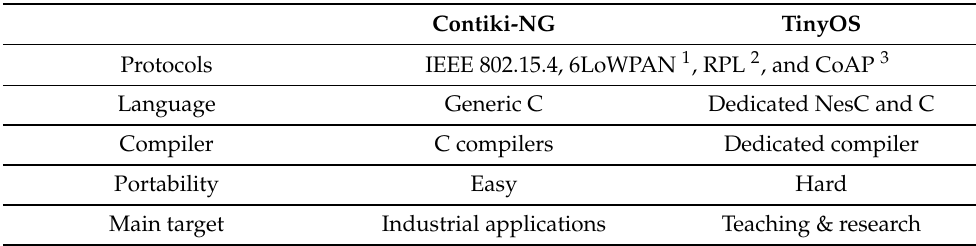
Table 1. Contiki-NG vs.